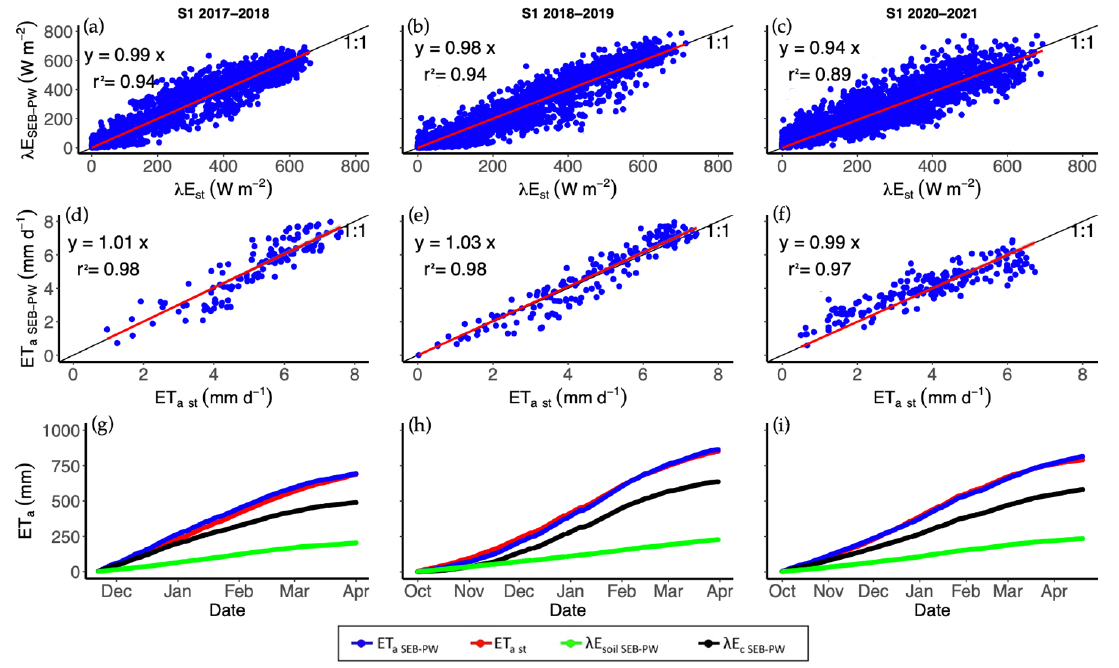
Figure 13. Relationships between modeled (SEB–PW) and measured (ST) hourly λ E ( a – c ) and daily ET ( d – f ), and cumulative actual ET (ETa SEB–PW , and ETa st ), soil E ( λ E soil SEB–PW ), and crop T ( λ Ec SEB–PW )